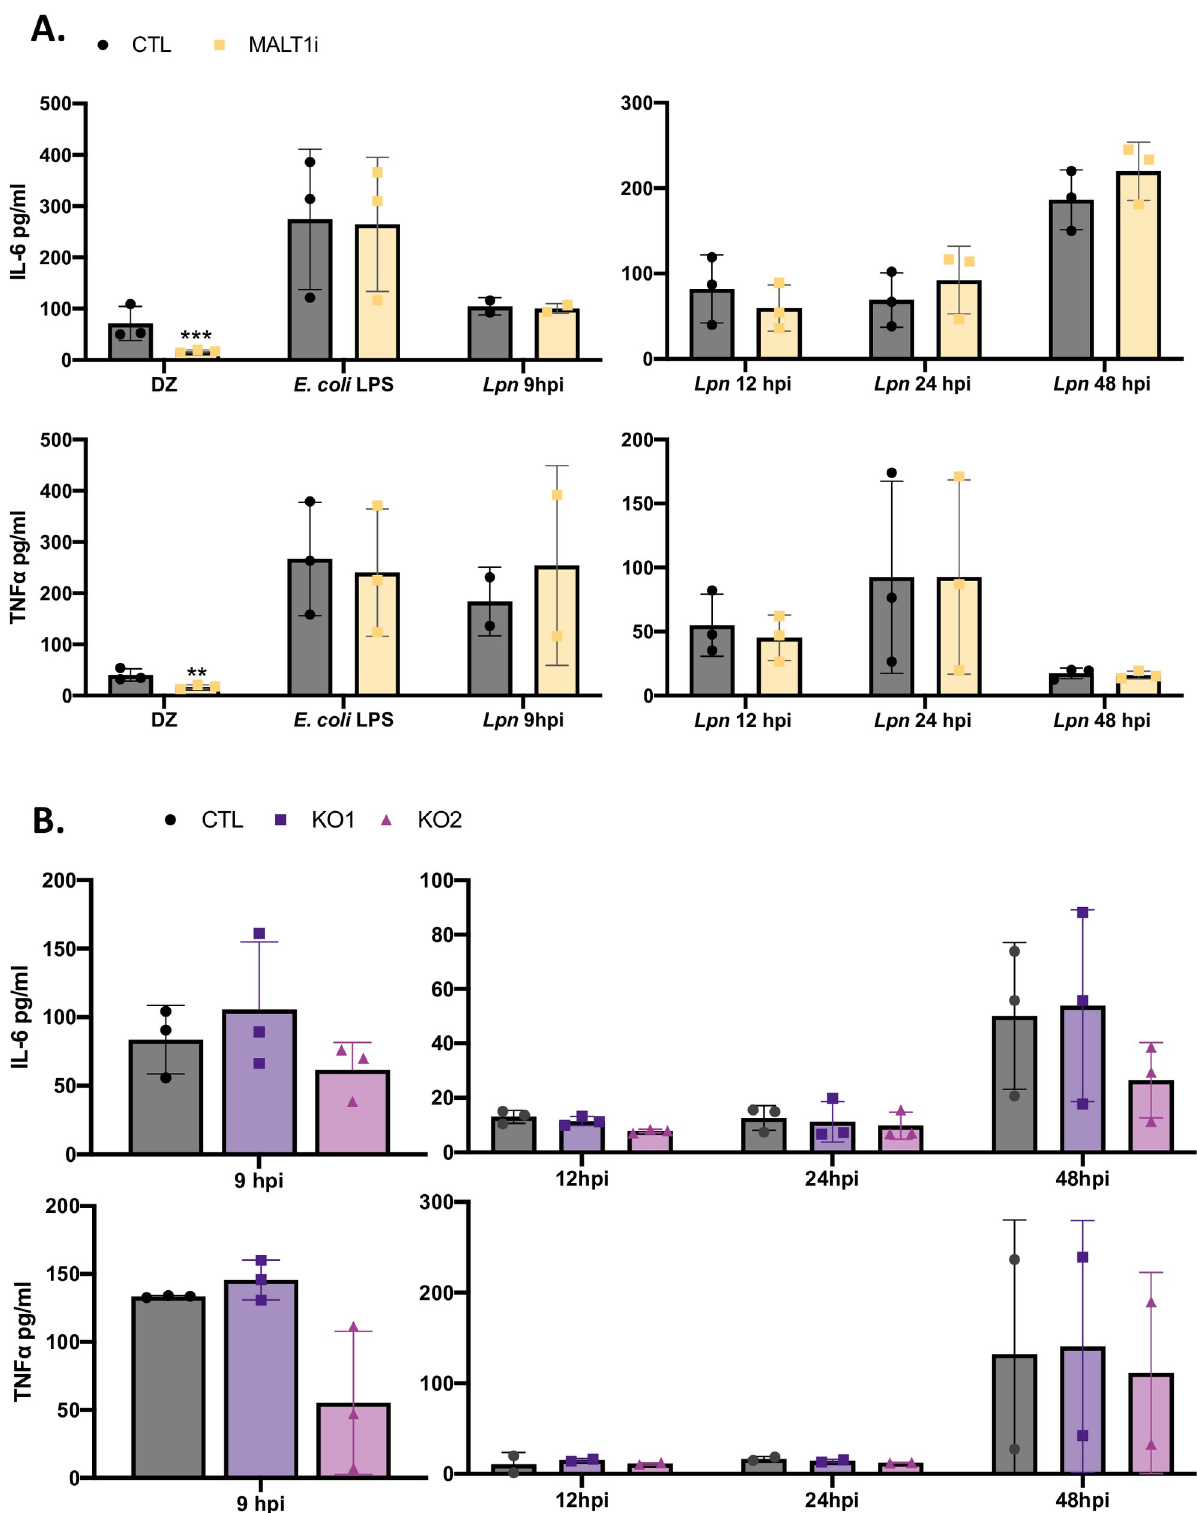
Fig 9. Assessing the requirement for C-type lectin receptors in the cytokine response of human macrophages to L . pneumophila infection. (A) U937 cells were pre-treated with either the MALT1 inhibitor Z-VRPR-FMK (MALT1i, yellow bars) or the vehicle control, DMSO (CTL, black bars). They were then exposed to either depleted zymosan (DZ) or E . coli LPS for 12 h (left panel), or infected for 9, 12, 24, or 48 h with strain 130b ( Lpn ) inoculated at a MOI 20 (for 9-h infection; left panel) or 0.5 (for 12, 24, and 48-h infections; right panel), and levels of secreted IL-6 (top) and TNF